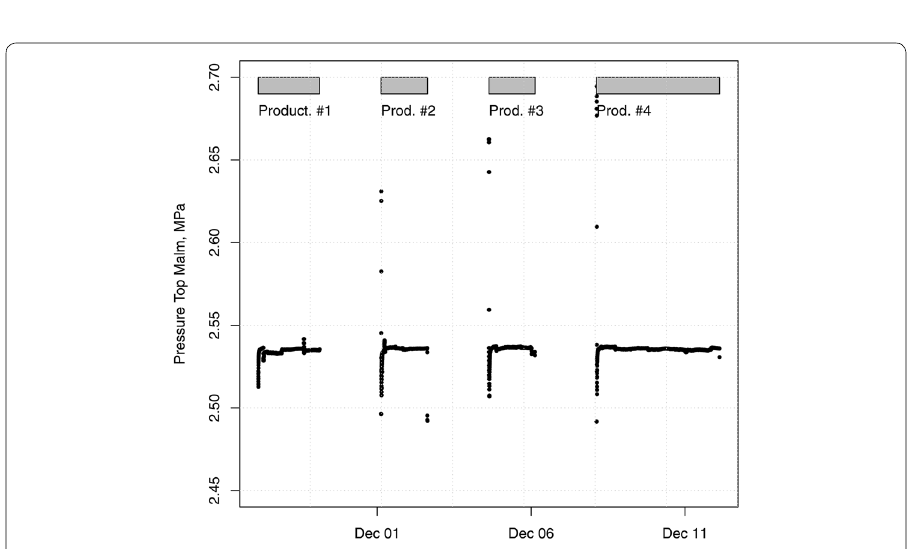
Fig. 7 Development of the pressure at top Malm. Grey bars indicate production stages